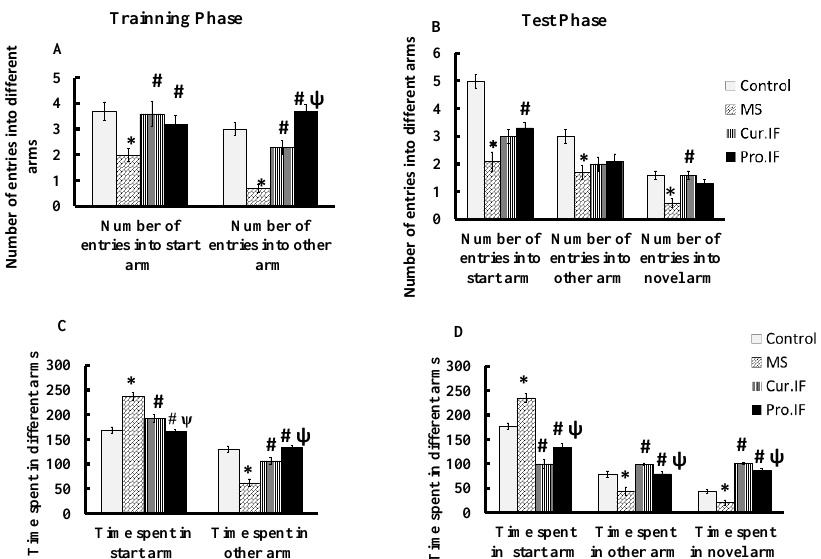
Figure 4. Effect of HFD and/or pro. and cur. IF on the short-term spatial memory tested by Y-maze in different studied groups: ( A ) the number of entries in the training phase; ( B ) the number of entries in the test phase; ( C ) the time spent in the training phase; ( D ) the time spent in the test phase. Data are expressed as mean ± SEM. ( n = 10). * HFD significant vis. control group, # pro. and cur. IF significant vis. HFD group, ψ pro. IF significant vise cur. IF.